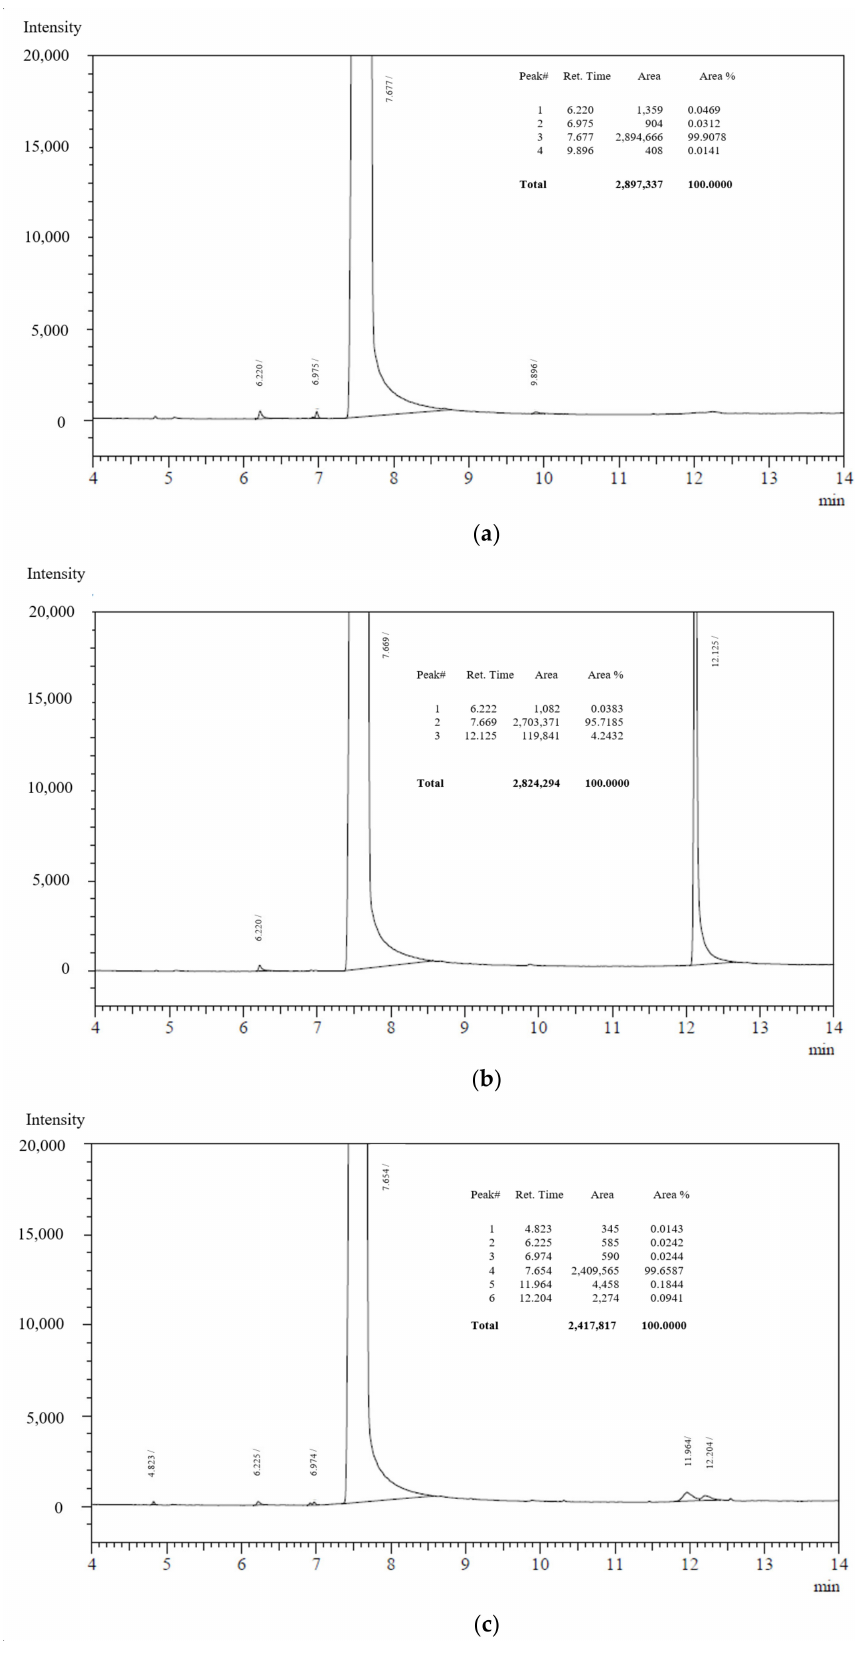
Figure 3. CG results: ( a ) capric acid, initial ( b ) capric acid thermal degradation, 500 h ( c ) capric acid thermal cycling degradation, 1000